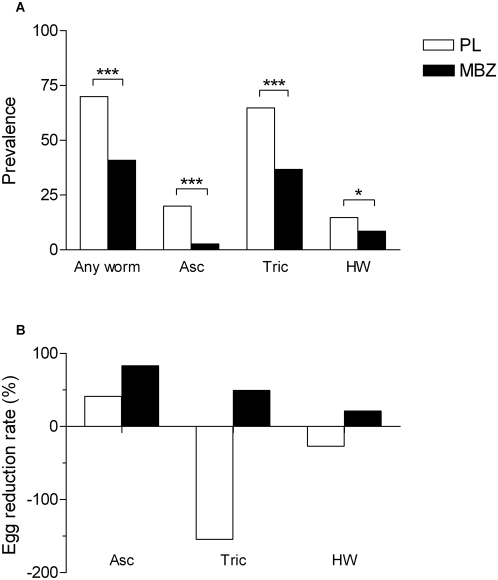
Effects of tri-monthly mebendazole or placebo treatment in infants on parasitology.A. Prevalence of infection after 4 rounds of tri-monthly mebendazole (n = 296) or placebo (n = 307) treatment on any worm positive infants, Ascaris lumbricoides positive infants (Asc), Trichuris trichuria positive infants (Tric), hookworm positive infants (HW). B. Egg reduction rate after 4 rounds of tri-monthly mebendazole (n = 296) or placebo (n = 307) treatment on Ascaris lumbricoides positive infants (Asc), Trichuris trichuria positive infants (Tric), hookworm positive infants (HW). * P = 0.01–0.05, *** P<0.001.